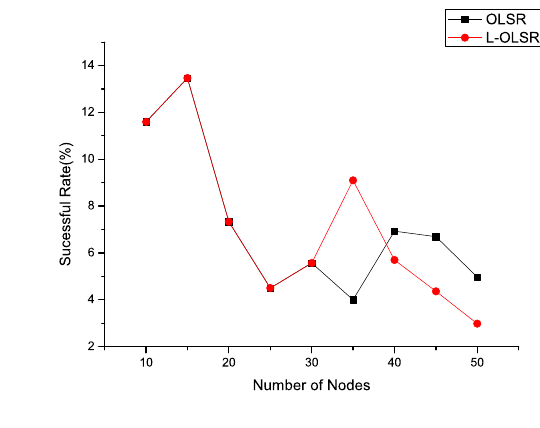
Fig.11. Delivery success rate (DSSS 5_5 M).